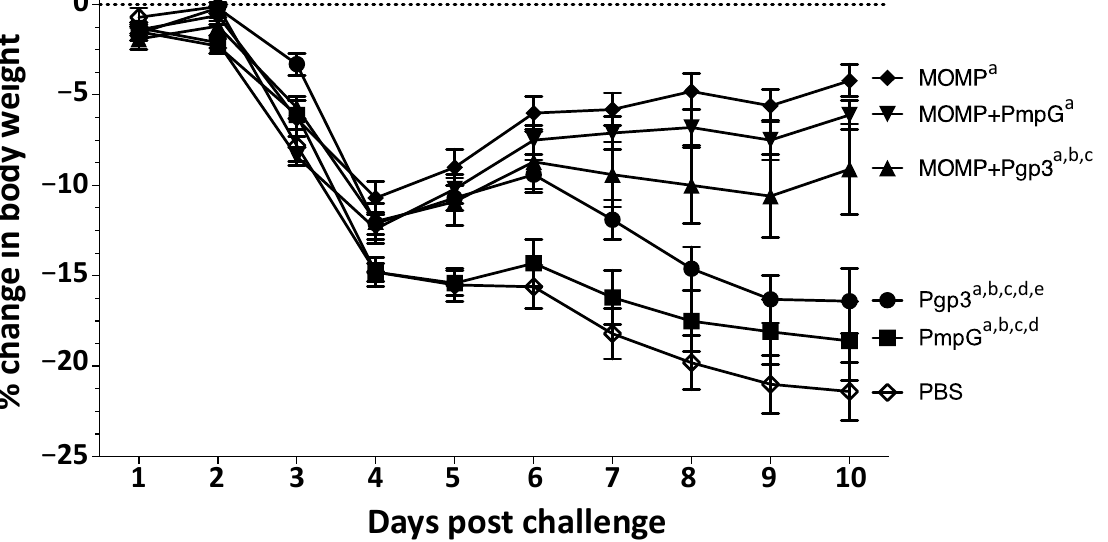
Figure 8. Body weight loss following the i.n. challenge with C. muridarum . Mice were immunized with several vaccine formulations and challenged i.n. with 10 4 C. muridarum IFU at four weeks after the last immunization. Daily percentage changes in mean body weight following the i.n.